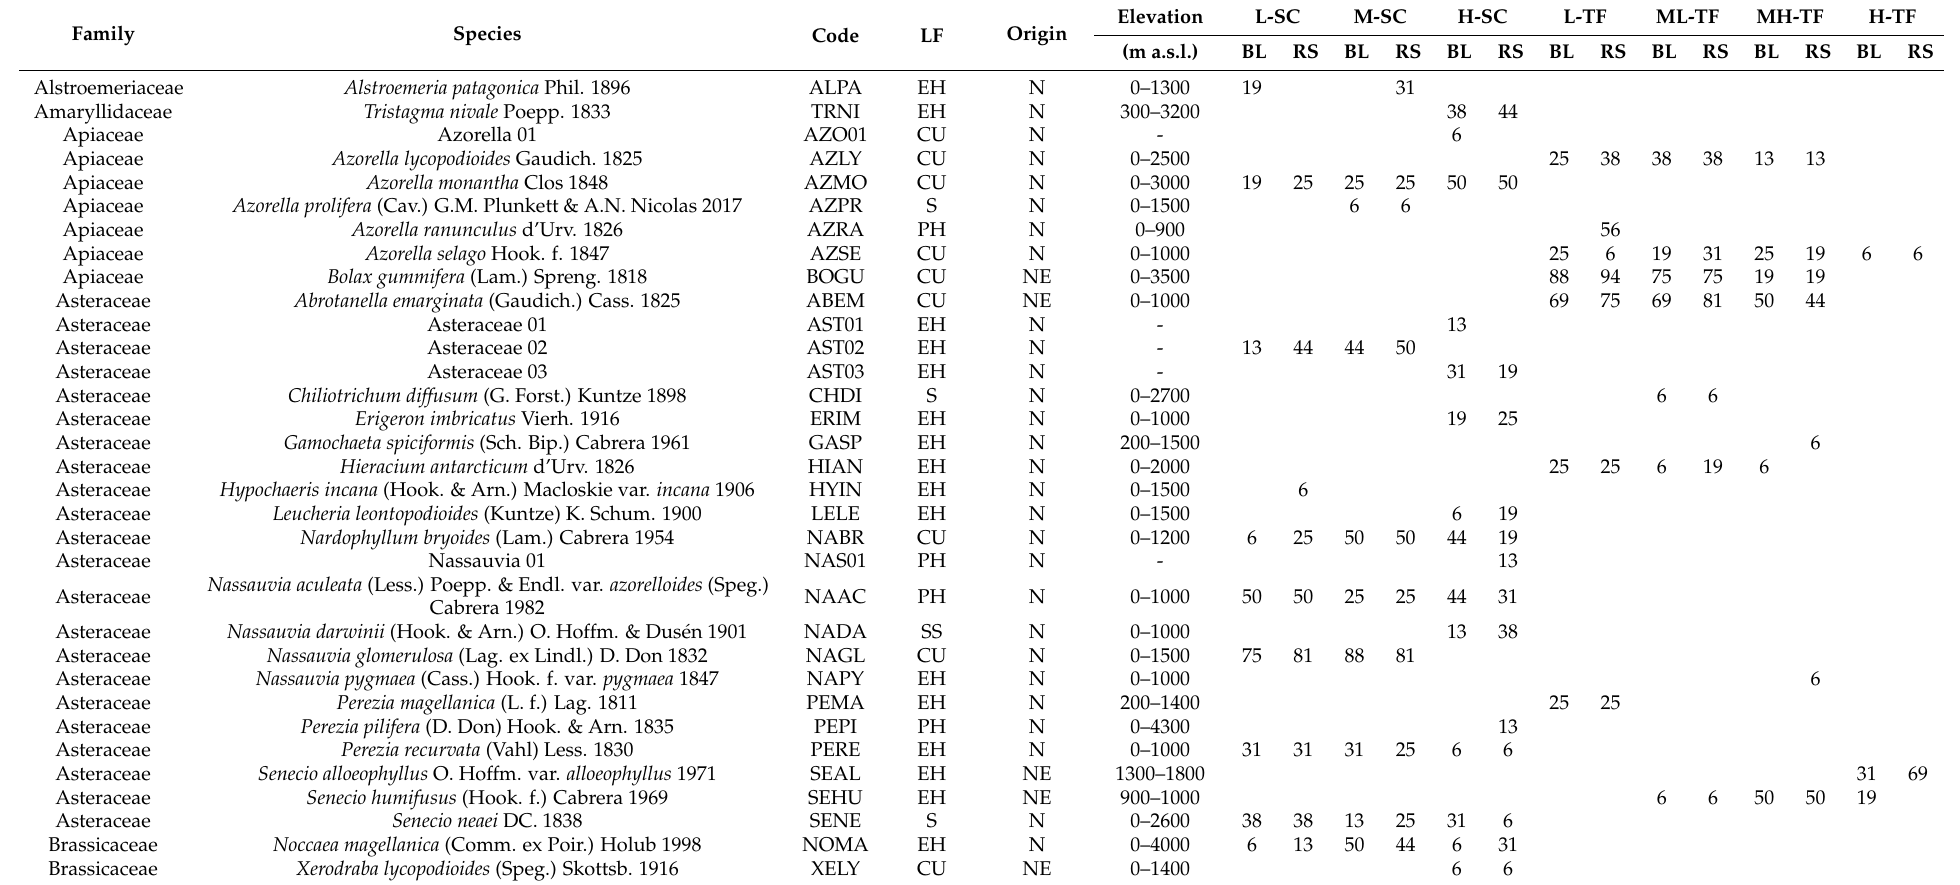
Table A1. Occurrence frequency (%) of alpine vascular plant species in summits (L = low, M = medium, ML = medium-low, MH = medium-high, H = high) of South Patagonian sites, immersed in grassland (SC = Santa Cruz), or forest (TF = Tierra del Fuego). Data are differentiated by base line (BL) or re-sampling (RS). Life-form (LF) as S = shrub, SS = sub-shrub, EH = erect herb, PH = prostrate herb, CG = caespitose grass, RG = rhizomatous grass, CU = cushions, F = fern), origin as N = native, NE = native endemic of South Patagonia and/or southern regions of Chile; E = exotic, and elevation range (m a.s.l.), are also provided. Species are ordered alphabetically by Family.